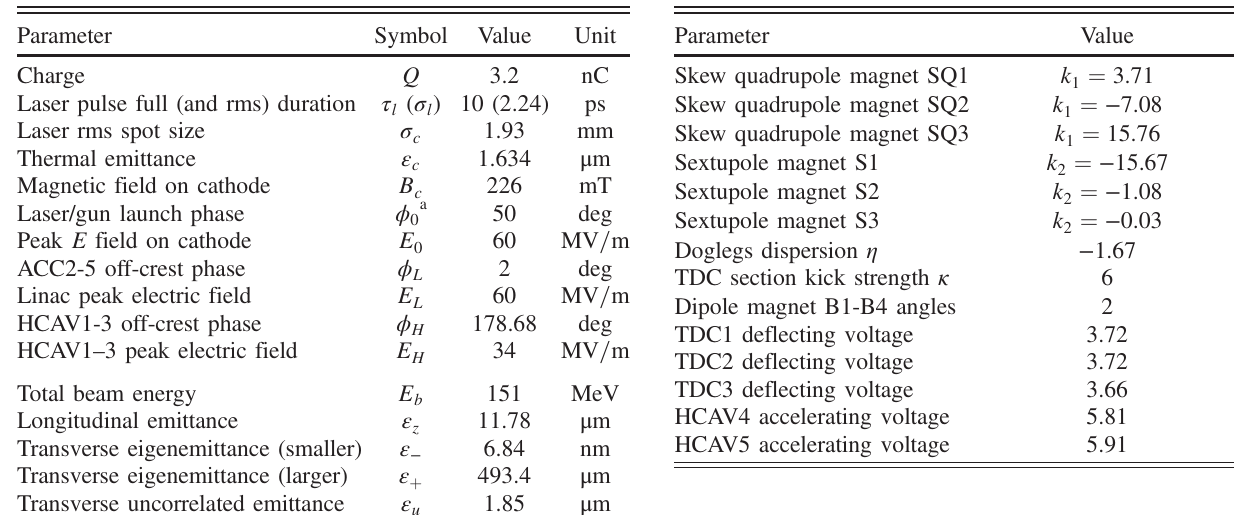
TABLE II. Beamline settings for the proposed photoinjector and achieved normalized-emittance values at the end of the beamline. The quantities ε (cid:4) ≡ γ ˜ ε (cid:4) where ˜ ε (cid:4) is defined in Eq. (8).